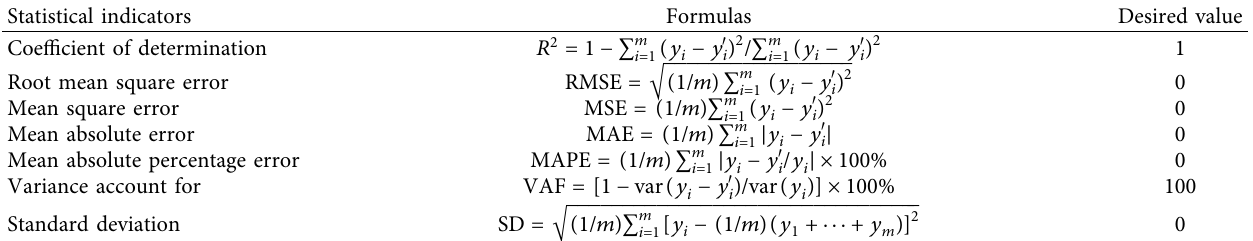
Table 5: Statistical indicators of blasting PPV prediction effect.